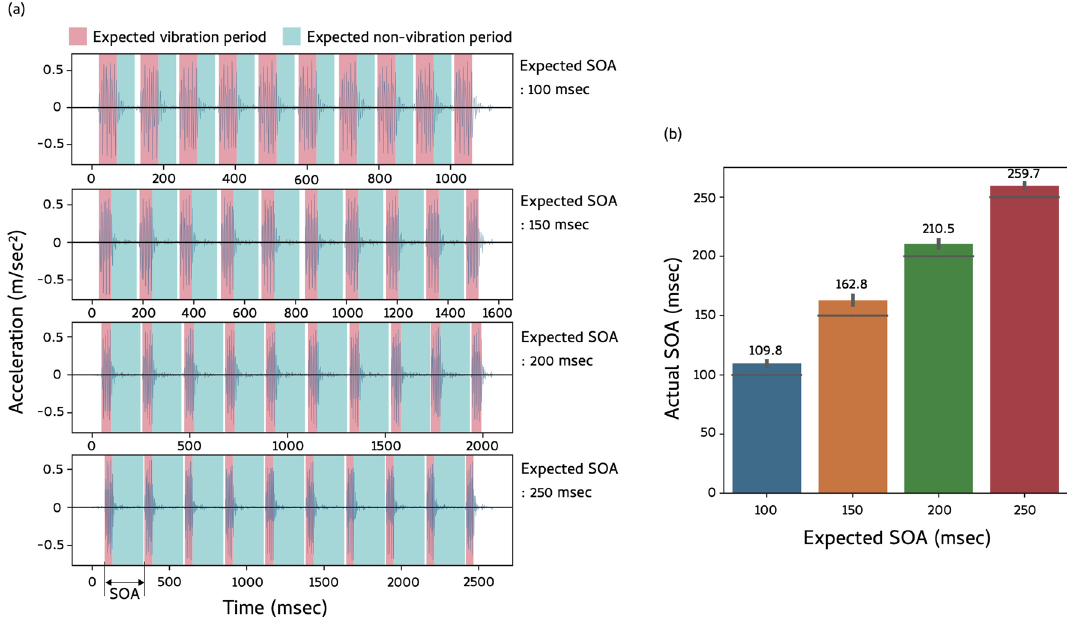
Figure 6. ( a ) Acceleration patterns of Google Pixel 5 when subject to a train of ten vibrations at four levels of SOA. ( b ) Mean SOAs as a function of expected SOA. Values above each bar indicate mean SOAs for each SOA condition. Error bars denote standard errors of